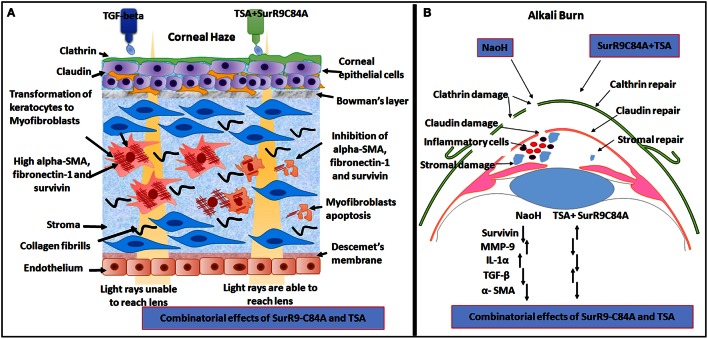
Schematic representation to summarize effects of TSA and SurR9-C84A in corneal haze and alkali burn rabbit model. (A) In corneal haze, TGF-β1 in myofibroblast cells overexpress survivin, α-SMA, fibronectin, and collagen IV. However, TSA in TGF-β1 induced myofibroblast cells, stabilizes survivin protein expression to make a cell cycle arrest, and inhibit the HDAC activity through the Smad pathway. SurR9-C84A protein after dimerizing with wild type over-expressing survivin present already in myofibroblast cells treated with TSA, activate different kinases, and induces cell death to clear myofibroblast cells. (B) In case of alkali burn, the NaOH induced insult led to damage in clathrin and claudin layers. Inflammation in the conjunctival and corneal epithelium as seen by clathrin and claudin degradation, stromal vacuolation with an elevated expression of α-SMA, and infiltration of blood cells. But, the treatment of TSA and SurR9-C84A either alone or in combination, showed protective and healing effects on the same with reinstated expression of clathrin, claudin, TGF-β, and survivin molecules. The schematic illustration of signaling pathway and absorption of Fe-bLf NCs in various organs was generated by modifying images purchased in the PPT Drawing Toolkits-BIOLOGY Bundle from Motifolio, Inc.